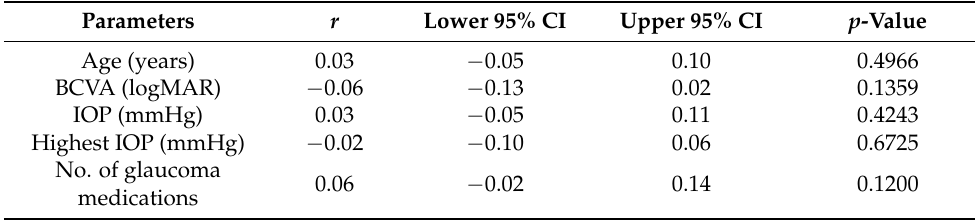
Table 2. Possible associations among SCs and various continuous parameters.